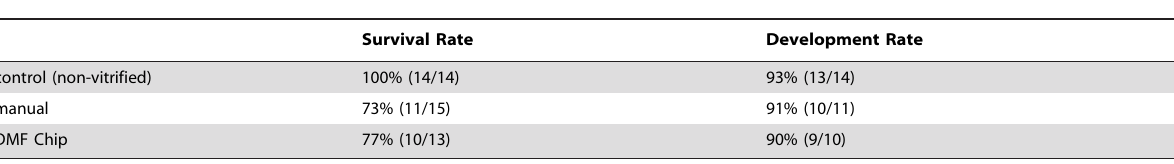
Table 1. Summary of vitrification